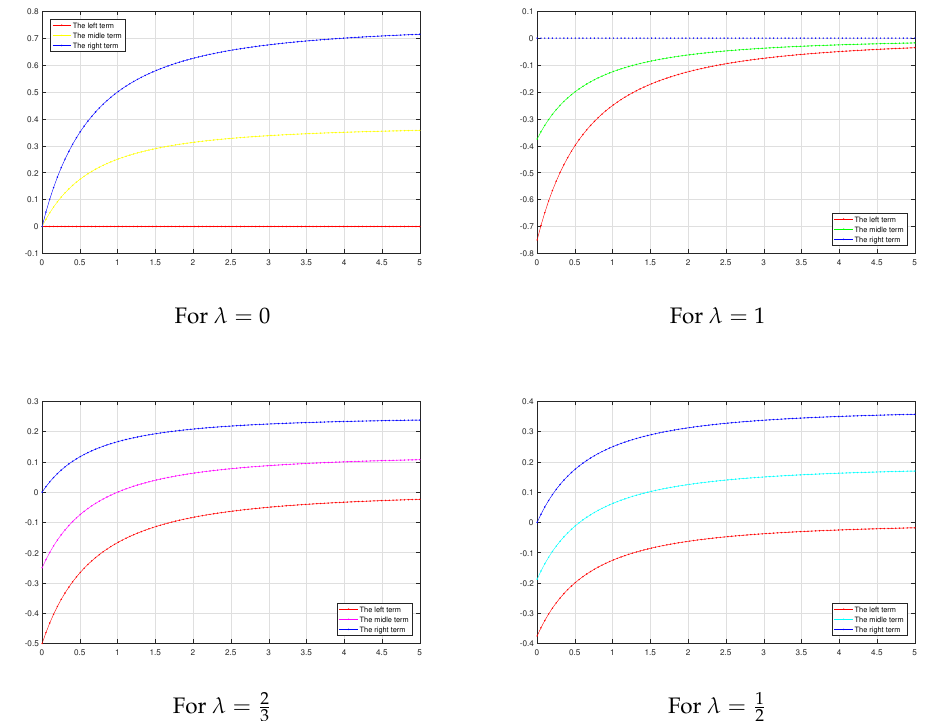
Figure 1. Graph of both sides of (10) in Example 1, depending on α and λ , computed and plotted with